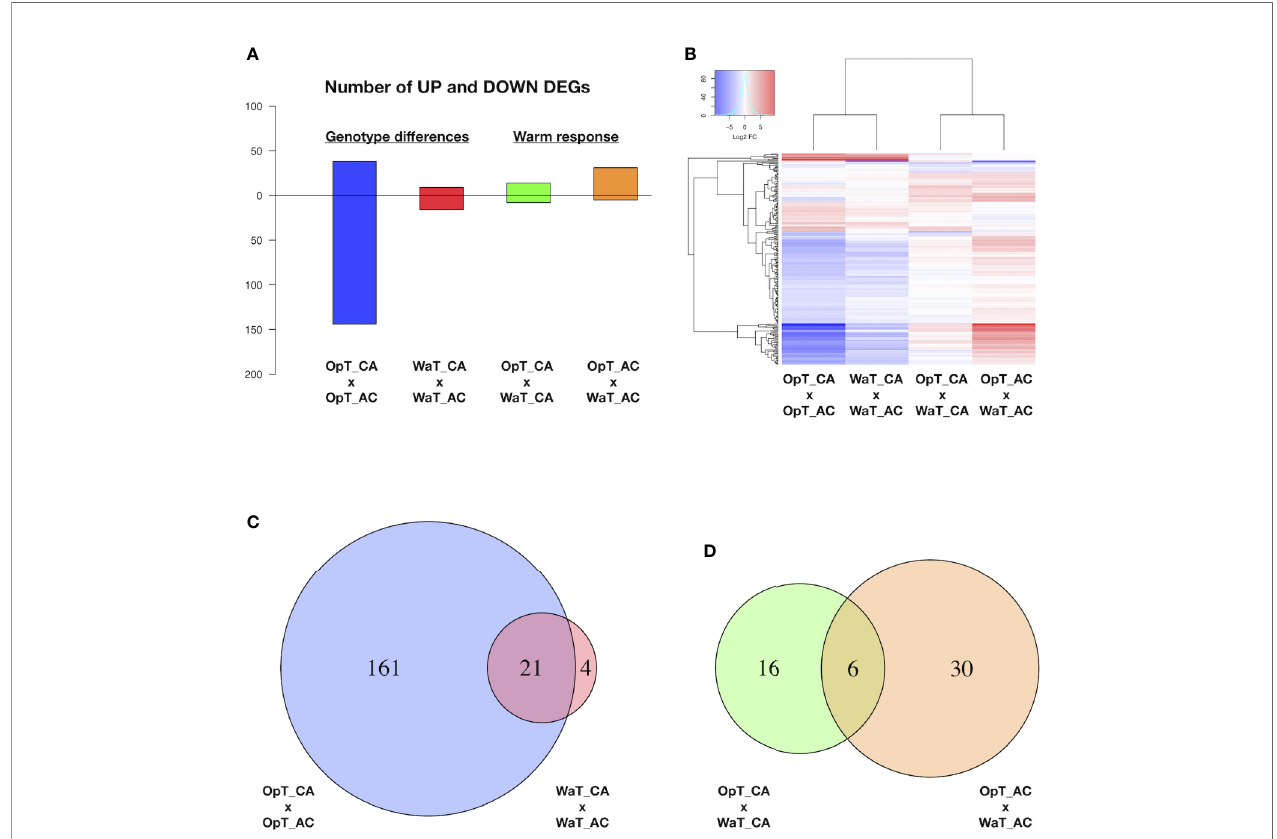
FIGURE 2 | RNAseq analysis of two coffee genotypes under two temperature conditions. (A) Number of differentially expressed genes (DEGs) between coffee genotypes, cvs. Acauã and Catua ı ́ , at stated temperature (OpT or WaT; named “ genotype differences ” in fi gure) and between the same cultivar at different temperatures (named “ warm response ” ). (B) Heat map with up and down-regulated DEGs shown in A. (C) Venn diagram showing the DEGs found between coffee genotypes at OpT and WaT conditions (genotype differences) highlighting that the warm temperature causes a drastic reduction on DEGs. (D) Venn diagram showing the DEGs responsive to WaT for each coffee genotype (warm response). Details of DEGs, including genome identi fi cation, annotation and expression analysis, are available in Table S2 . Labels: OpT, optimal temperature (23/19°C, day/night); WaT, warm temperature (30/26°C, day/night); CA, cv. Catua ı ́ ; AC, cv. Acauã. OpT_CA, WaT_CA, and WaT_AC were composed of fi ve repetitions each, whereas OpT_AC had four